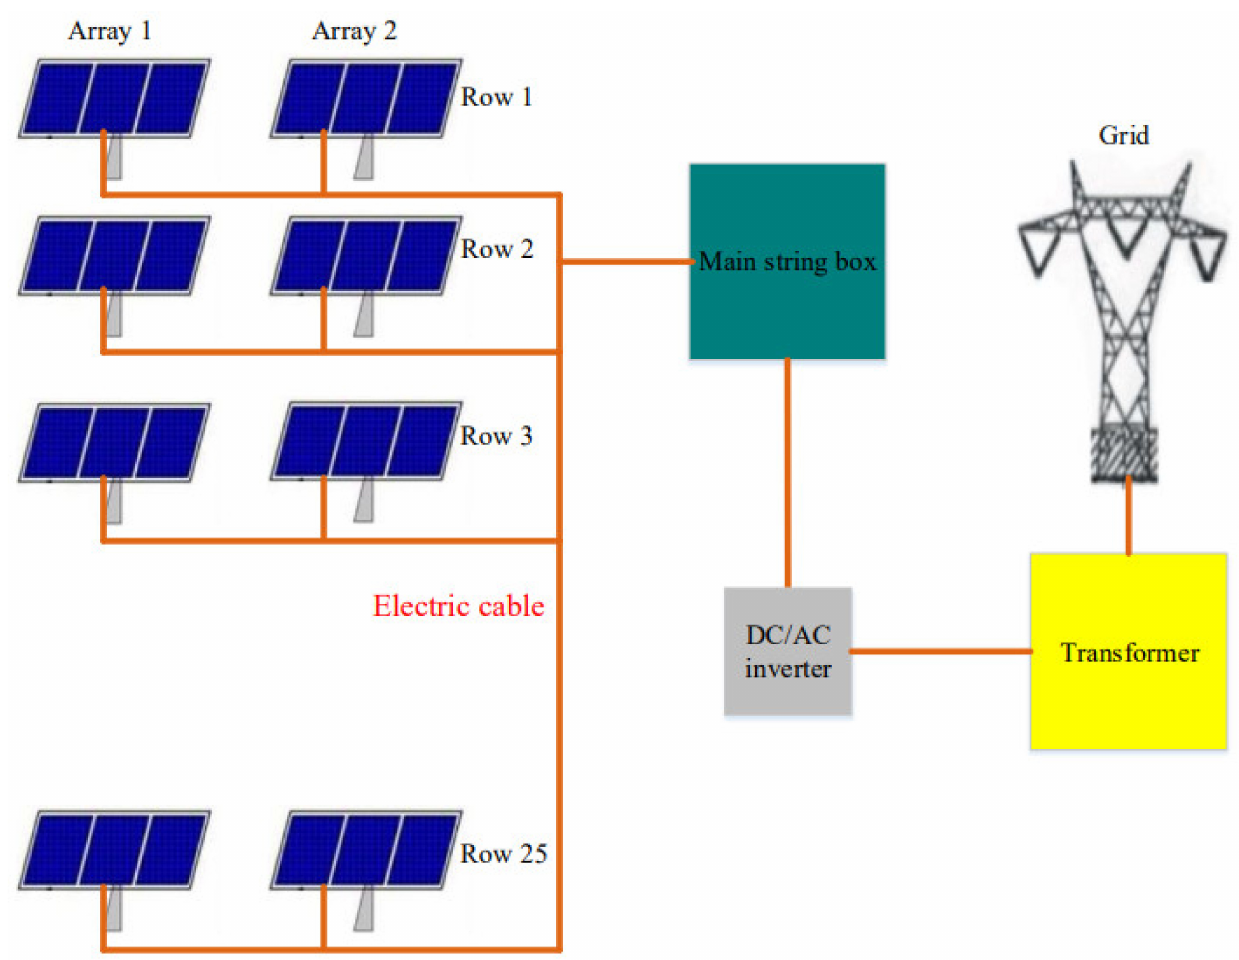
Figure 15. Layout of a block in 10 MW solar power